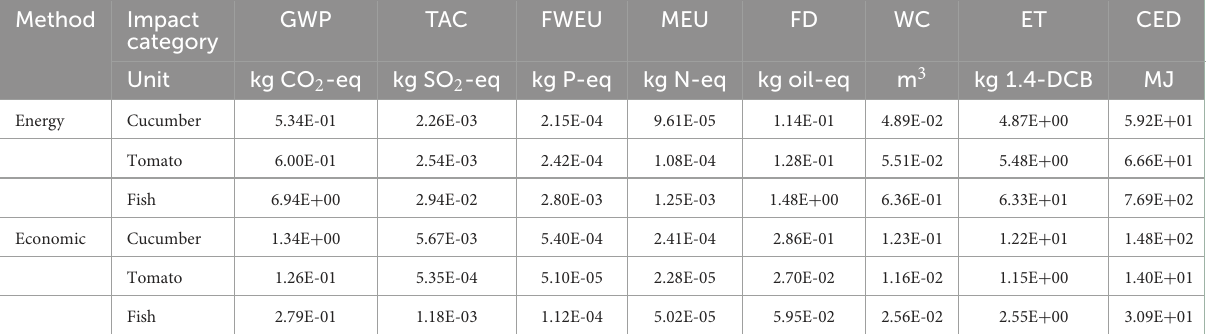
TABLE 4 Comparison of the results based on different allocation approaches based on energy and economic allocation (per 1kg of each